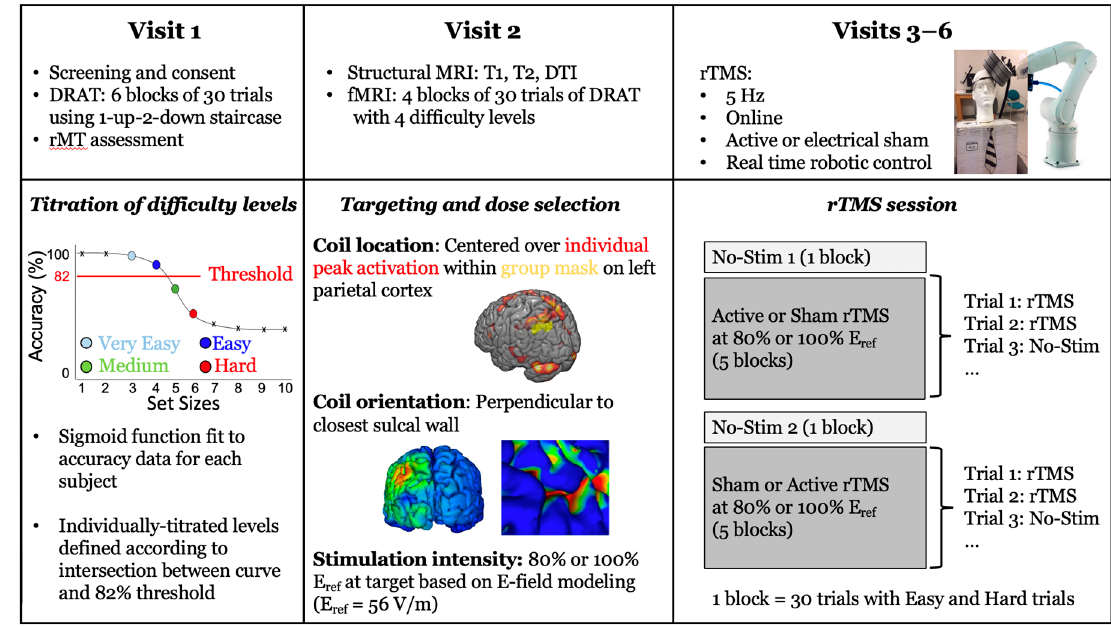
Figure 2. Illustration of the full experimental protocol across 6 visits. For visits 1 and 2, data processing procedures are illustrated in the bottom panel. For visits 3–6, the bottom panel illustrates the experimental procedure in greater detail (T1: T1-weighted images, T2: T2-weighted images, DTI: diffusion tensor imaging, rTMS: repetitive transcranial magnetic stimulation).